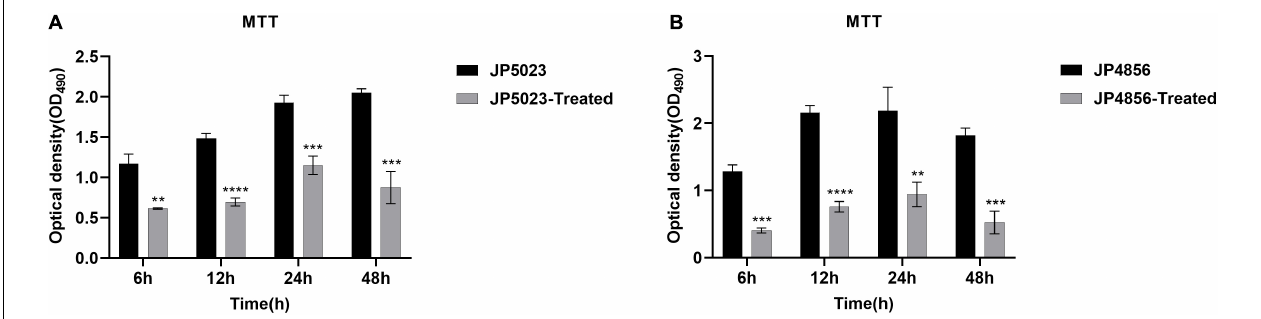
FIGURE 7 | The effect of subinhibitory concentration of SYG-180-2-2 on the metabolic activity of MRSA strains JP5023 (A) and JP4856 (B) biofilm. ** P < 0.01, *** P < 0.001, and **** P < 0.0001.